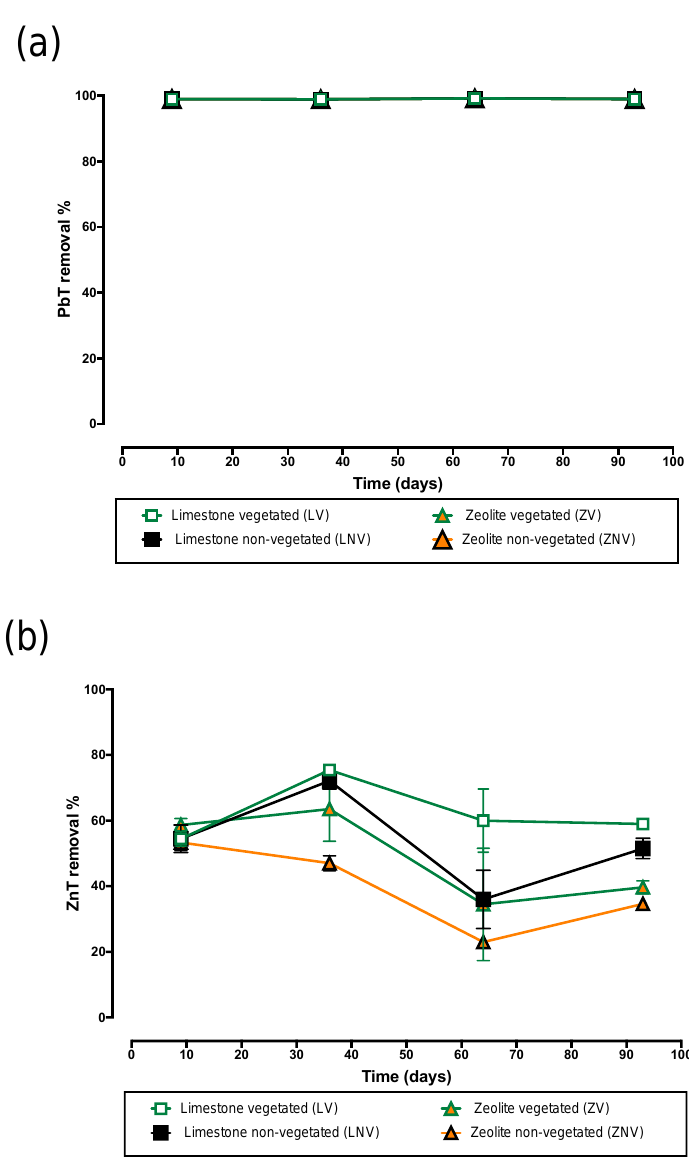
Figure 4. Lead ( a ) and zinc ( b ) removal in the zeolite and limestone cells (vegetated and non-vegetated). Data corresponds to average values, and error bars indicate minimum and maximum values for each cell type. When measurements were reported below the limit of detection, half of the corresponding value was considered as the actual concentration.